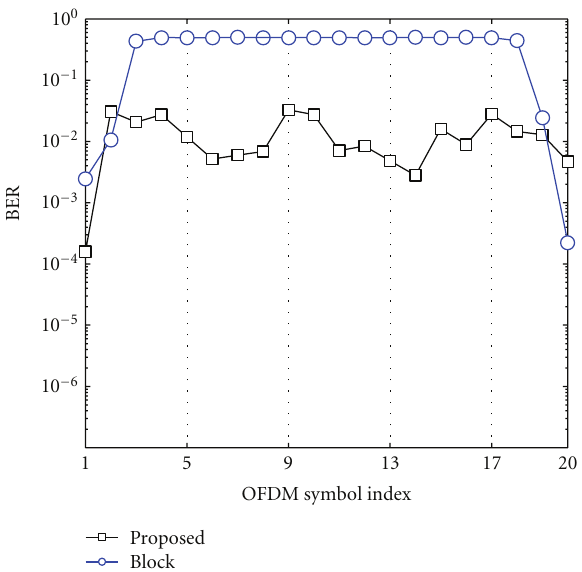
Figure 15: Performance comparison of block-based and proposed